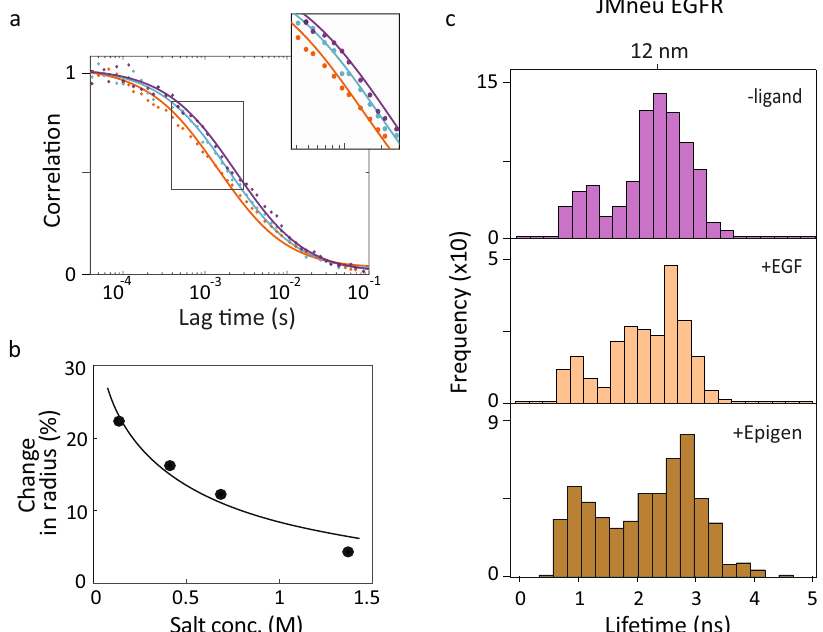
Fig. 3 Charged residues implicated in extracellular/intracellular conformational coupling. a FCS curves of WT EGFR (dots) were fi t (solid lines) to extract a diffusion time of 1.5 ms in the presence of EGF (orange), 2.2 ms in the absence of EGF (purple), corresponding to a reduction of 22% in hydrodynamic radius, and 1.9 ms in the presence of Cetuximab together with EGF (cyan). b Percent change in hydrodynamic radius from FCS curves in the presence of EGF relative to in the absence of EGF (dots) as a function of salt concentration with Debye-Huckel fi t curve (solid line). c smFRET donor fl uorescence lifetime histograms for JMneu EGFR in POPC-POPS bilayer without ligand (top); with 1 μ M EGF (second); with 1 μ M epigen (bottom). All the three sets of histograms are statistically similar to each other (Supplementary Fig. 14). Source data are provided as a Source data fi